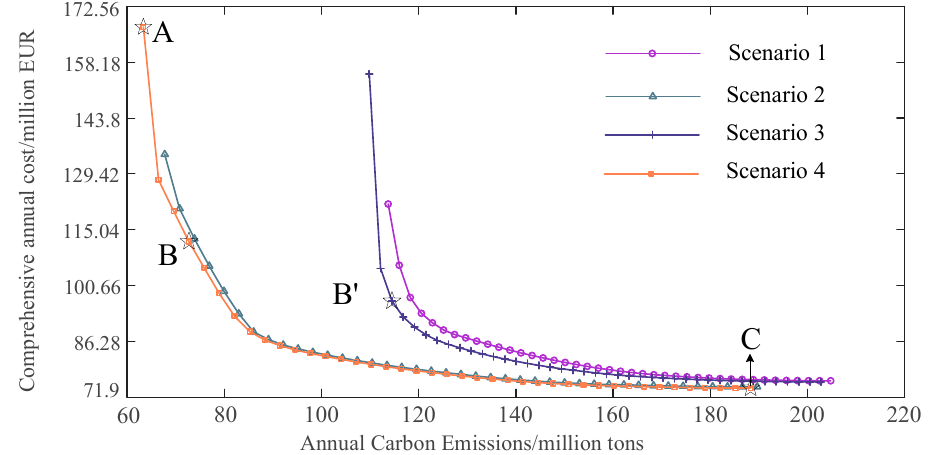
Figure 6. Pareto optimization results in different scenarios.